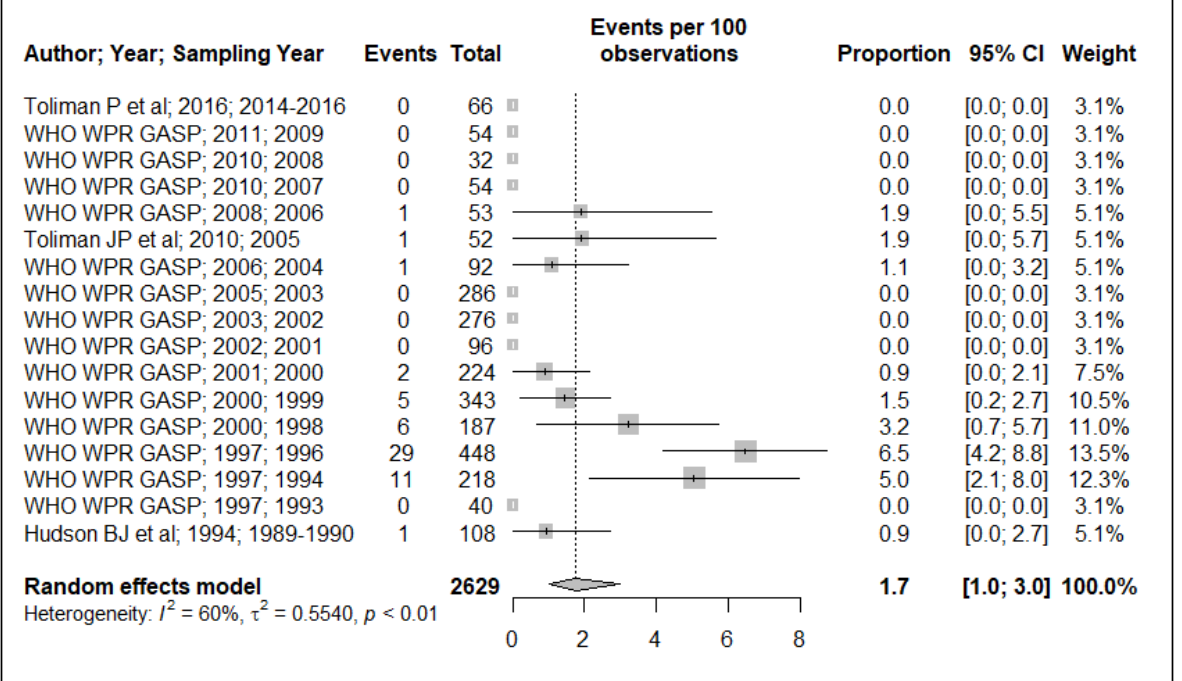
Figure 5. Quinolone (ciprofloxacin) resistance prevalence estimate.